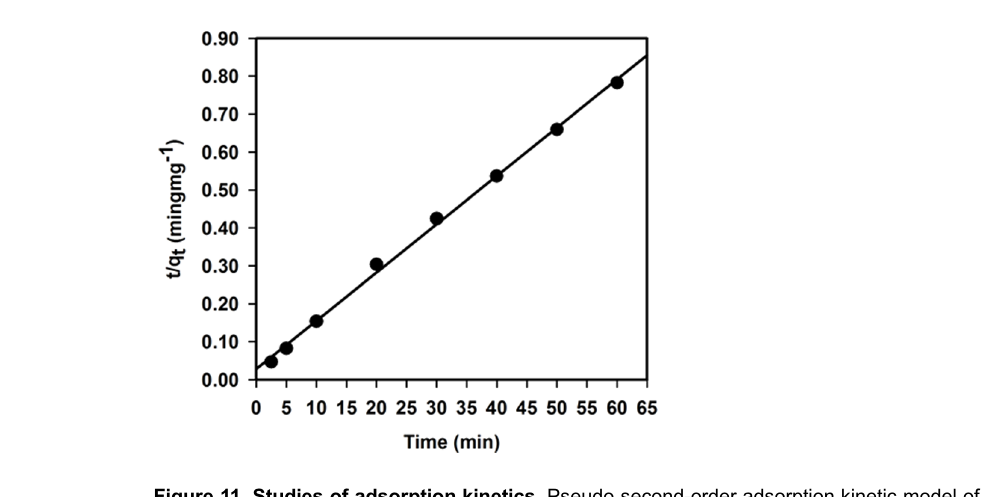
Figure 11. Studies of adsorption kinetics. Pseudo second-order adsorption kinetic model of Co(II) uptake on 25.0 mg Ag 2 O 3 -ZnO NCs at pH 5.0 and 25.0 ˚ C.